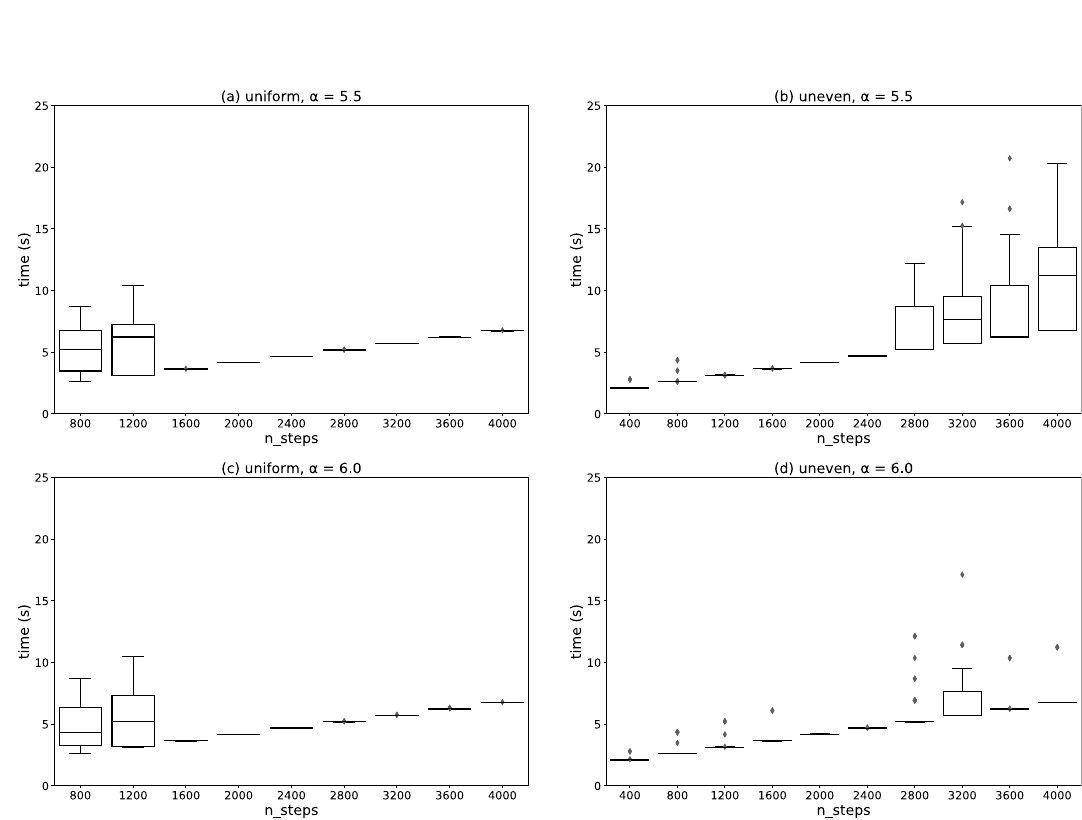
Figure 6. Box plots of execution time for ( a , c ) uniformly and ( b , d ) unevenly distributed data. The horizontal axis represents the number of SB time steps. The hyperparameters α = 5.5 in ( a , b ), and α = 6.0 in ( c , d